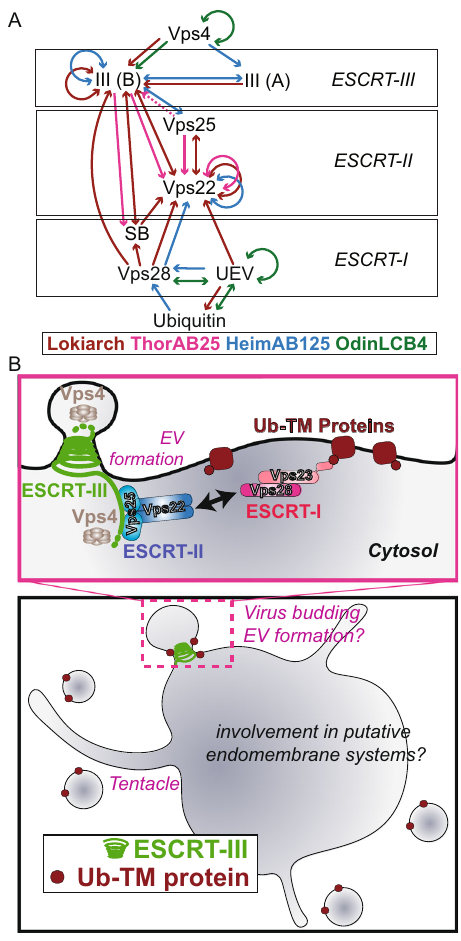
Fig. 5 Systematic reciprocal Yeast two-hybrid assays between Asgard ESCRT proteins and insights gained from investigating ESCRT from Asgard. A Summary of Y2H interactions. Molecules related to the Ub-